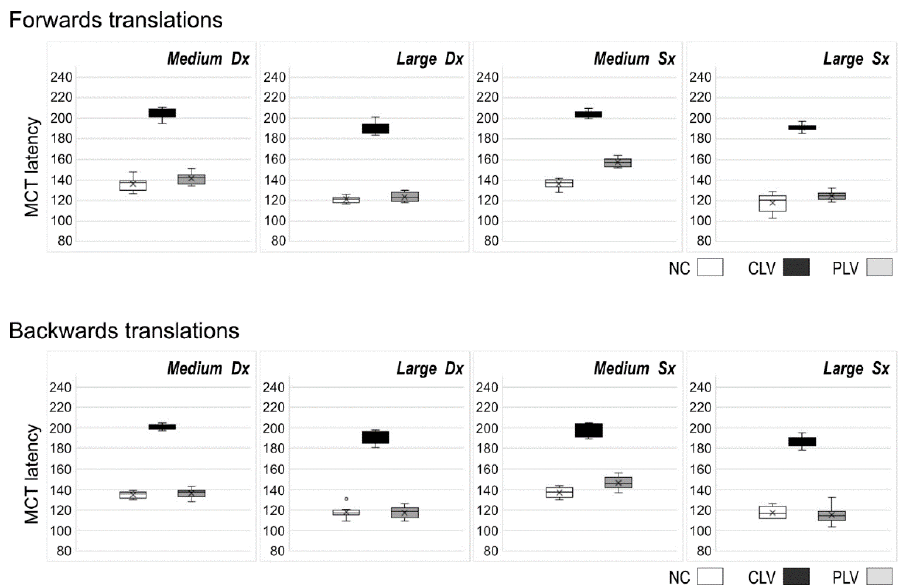
Figure 3. Sensory Organization Test (SOT) and Sensory Analysis (SA) scores: ( A ) Graphs show val- ues for each SOT condition (SOT1 – 6) and composite scores (COMP). NC: Normal Control; CLV: